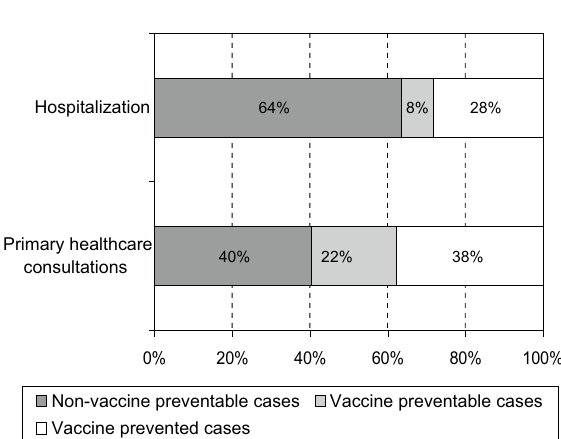
Figure 1. Impact of influenza vaccination in preventing primary healthcare consultations and hospitalizations for influenza among persons with chronic obstructive pulmonary